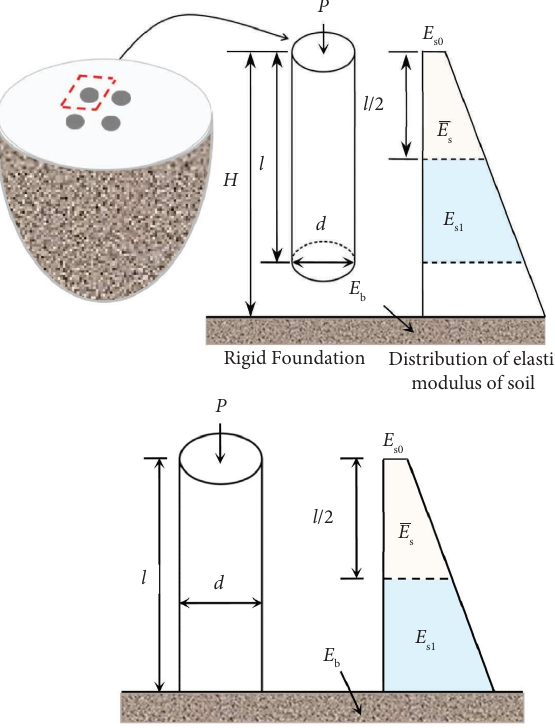
Figure 6: Defnition of pile-soil geometric